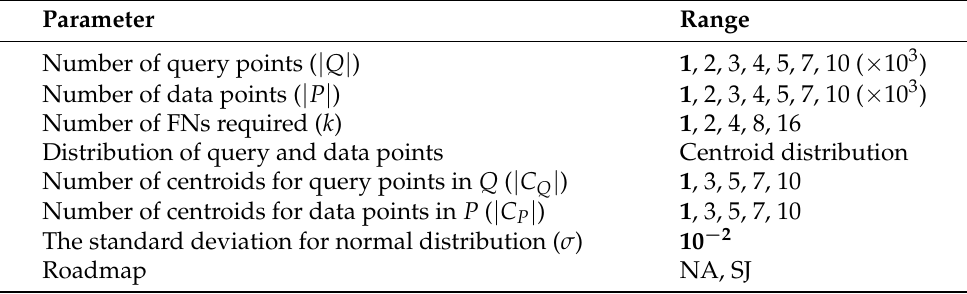
Table 8. Experimental parameter